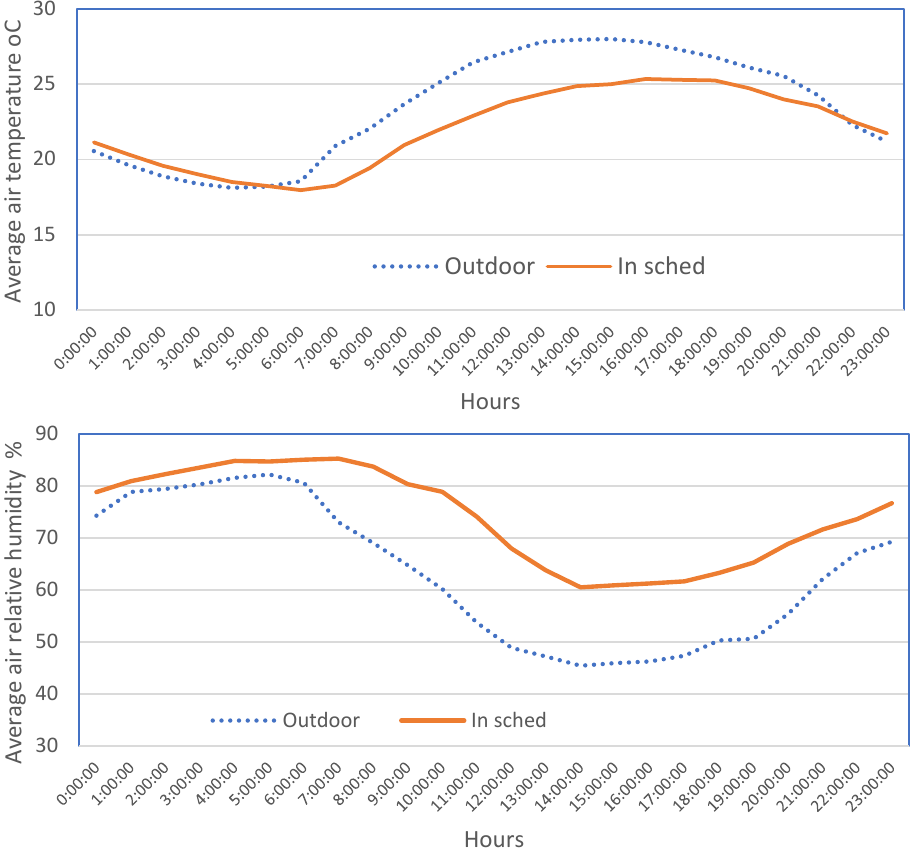
Figure 6. Average daily air temperature and relative humidity change in the first decade of July (7 cowshed).